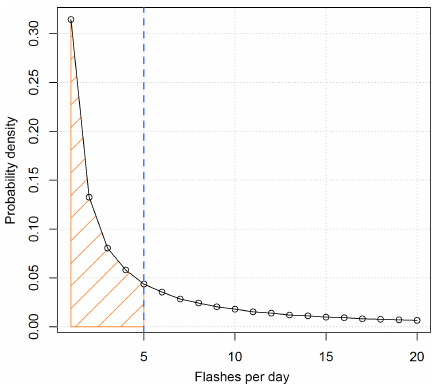
Figure 2. Empirical probability density distribution of daily flash numbers averaged over all grid cells within the entire investigation area during the period 2001 to 2014. Indicated are the separator be- tween the regimes’ TD (yes/no; vertical dashed line) and the prob- ability for a day with lightning that is not classified as TD (orange hatched